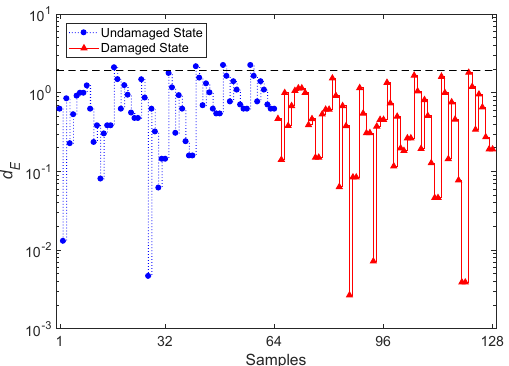
Figure 6. Evolution of the logarithmic distance value d E based on the classical Euclidean ‐ squared distance ‐ nearest neighbor (ESD ‐ NN) technique and on the CBFE algorithm, using the ARMA(33,33) model.